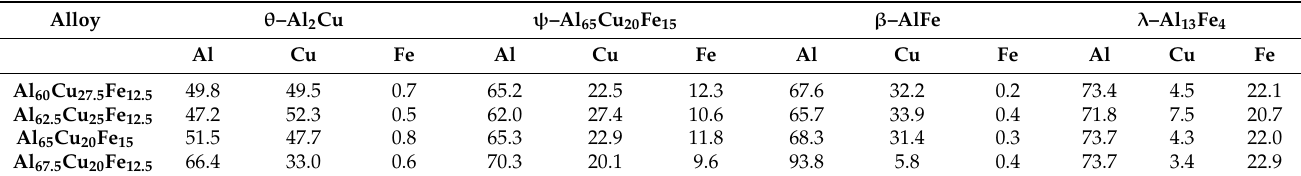
Table 4. Chemical composition of SCIPs in Al–Cu–Fe alloys (in at.%) studied in reference [95].